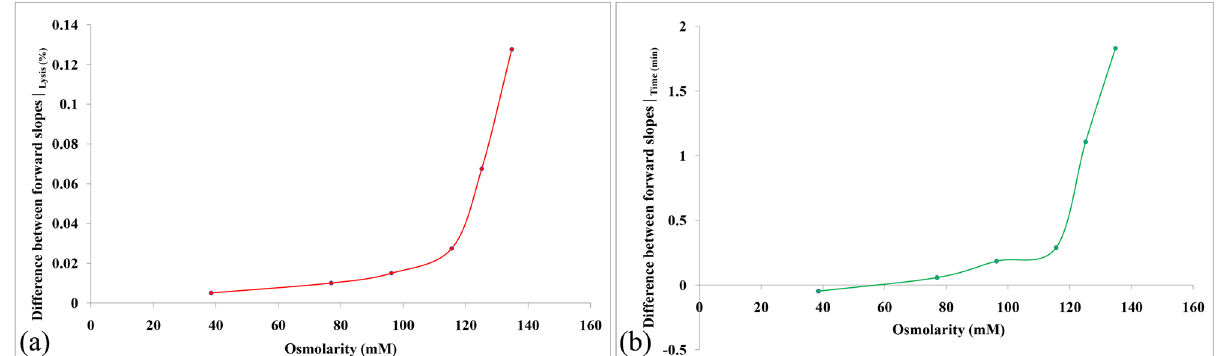
Figure 4. Difference between two forward slopes with ( a ) lysis percentage and ( b ) time as parameters are showing high values for higher osmolarities like 134.75 mM and 125.125 mM, which indicates nonlinear dependency between lysis percentage and PA amplitude at those data points, implying the presence of inflated erythrocytes in those samples.